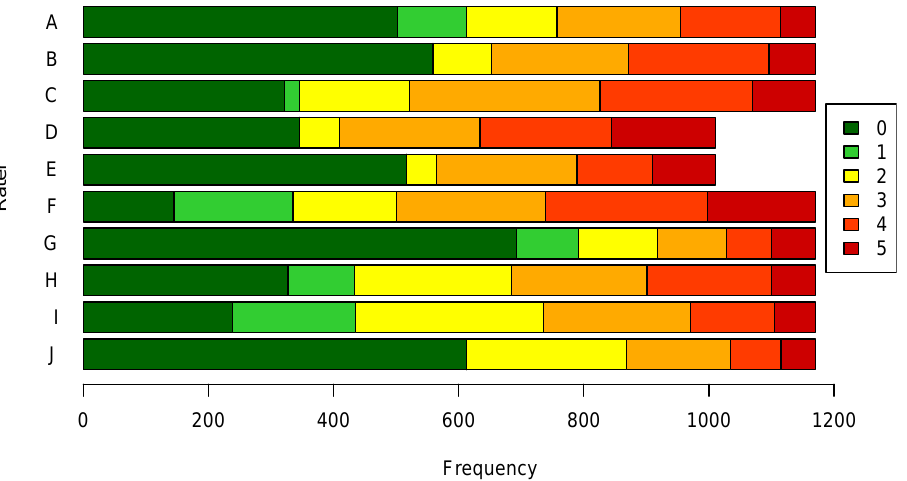
Figure 1. Summary of the individual sensory ratings for each rater/panelist; the scores of deviant smell run from 0 = ‘untainted’ to 5 = ‘strongly